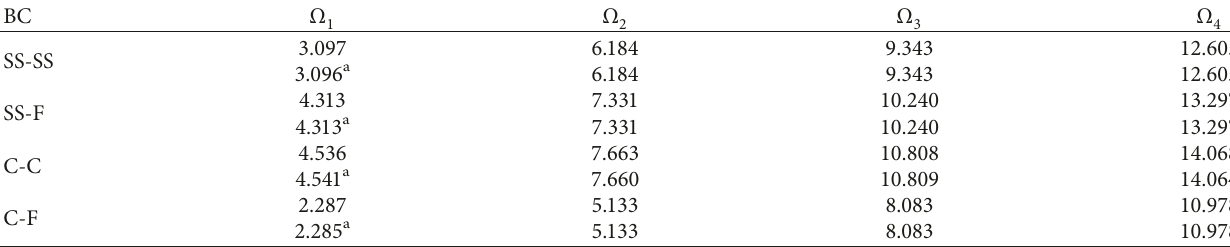
Table 4: The first four dimensionless frequencies